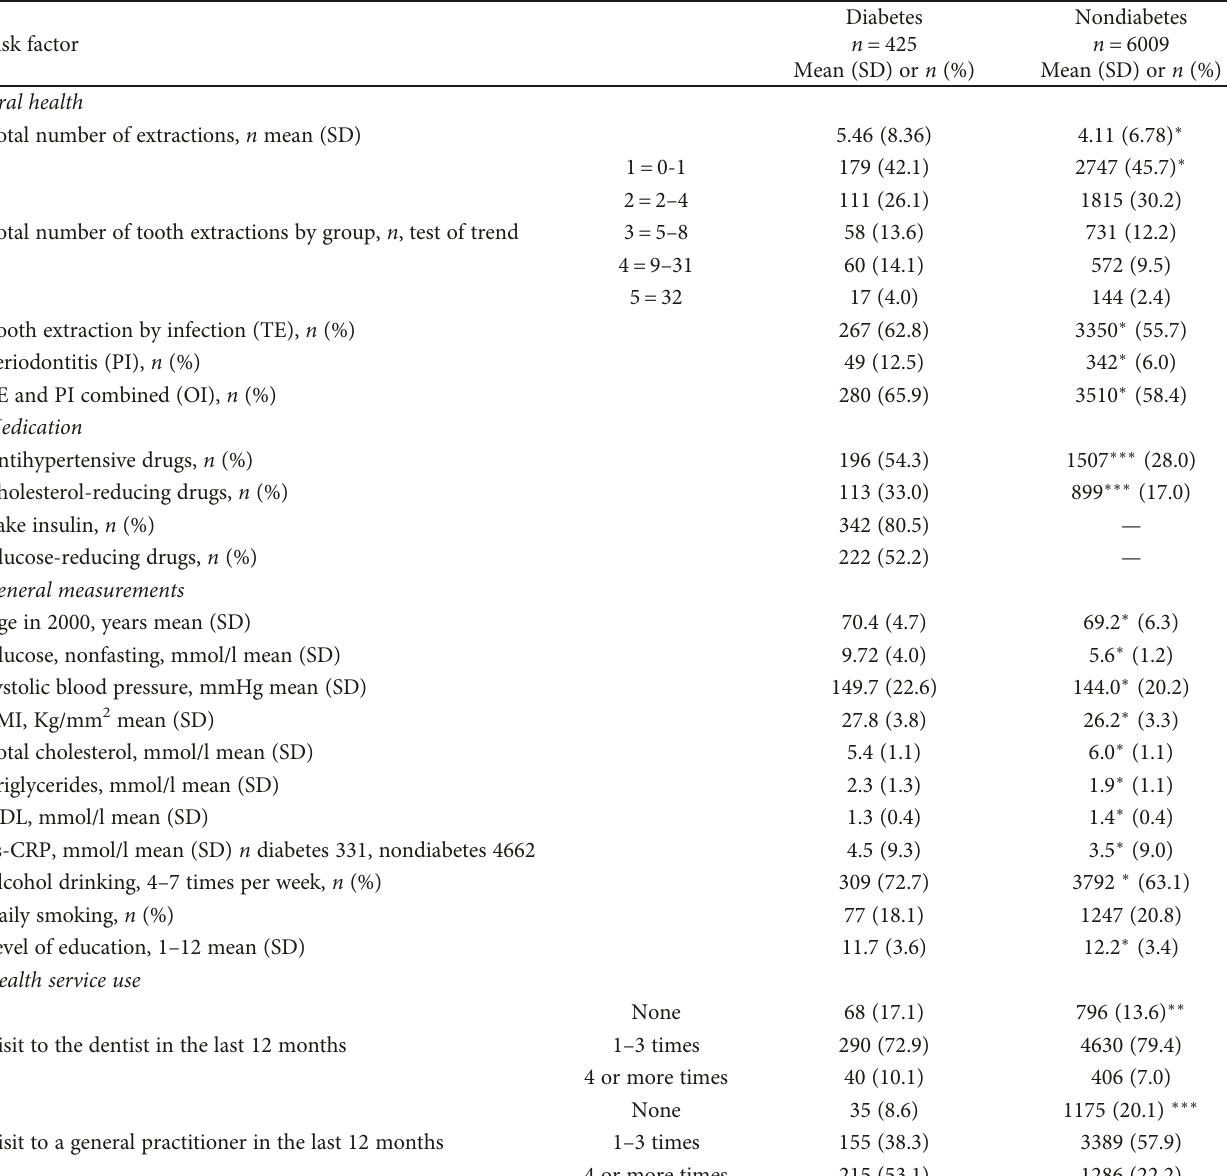
Table 1: Baseline characteristics among persons according to diabetes status. A 12 1/2-year follow-up of Oslo men of the Oslo II study of